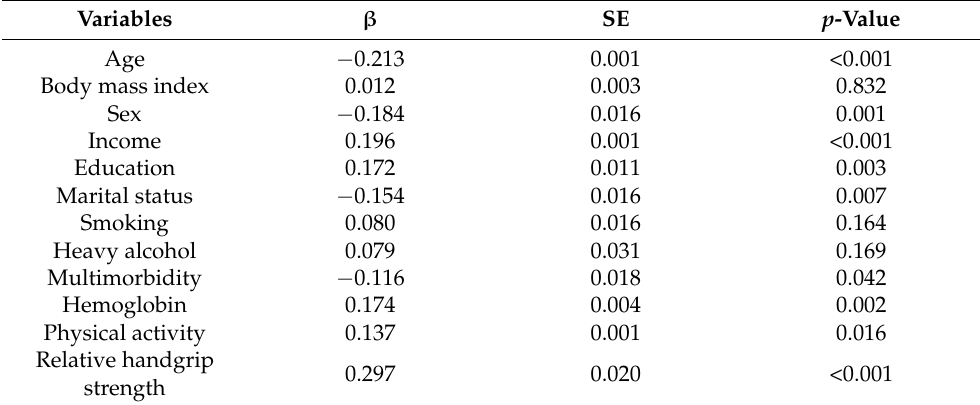
Table 2. Regression analyses for predictors of health-related quality of